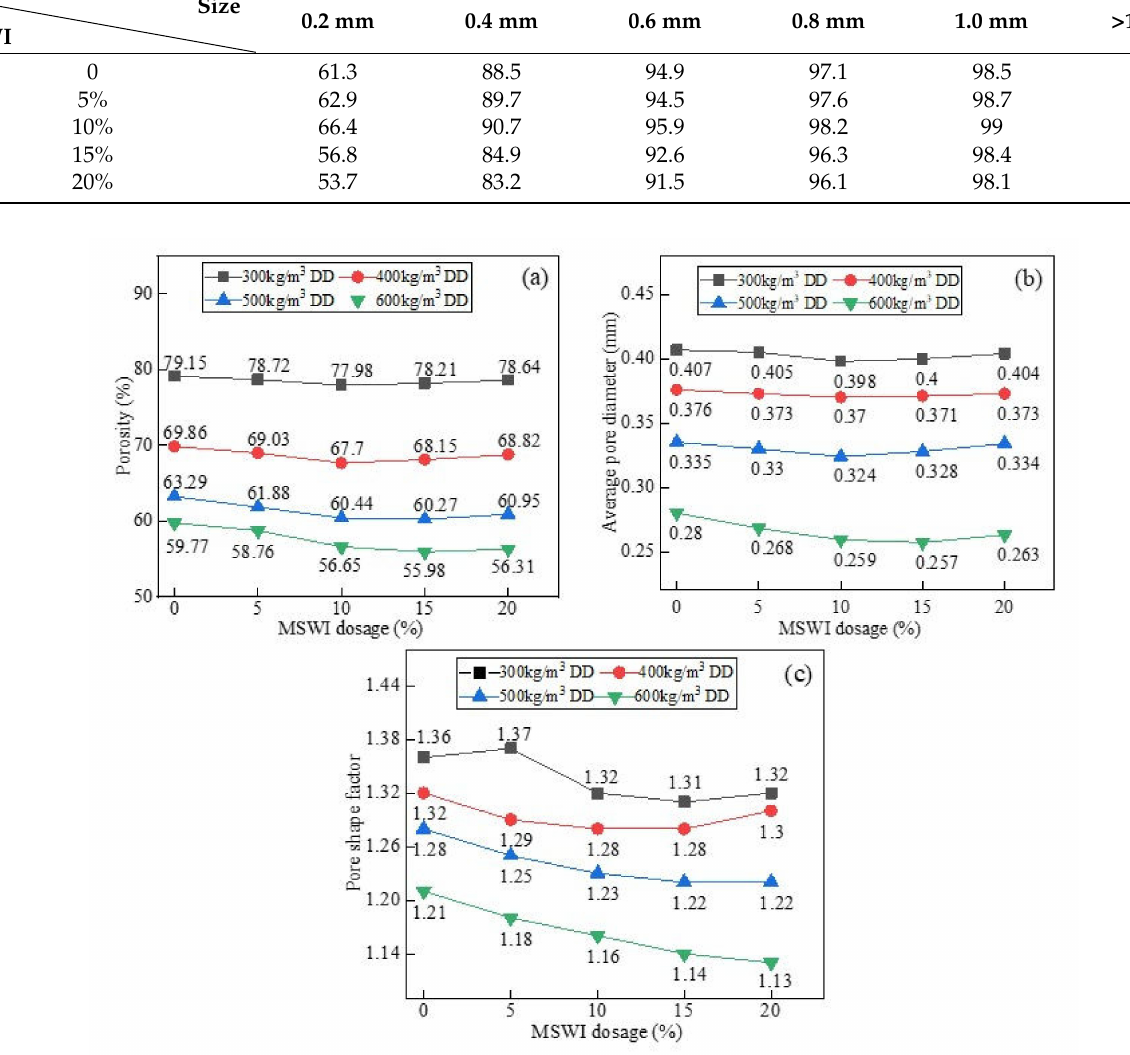
Figure 13. Porosity ( a ), average pore diameter ( b ), and pore shape factor ( c ) of the recycled foamed concrete with different MSWI powder